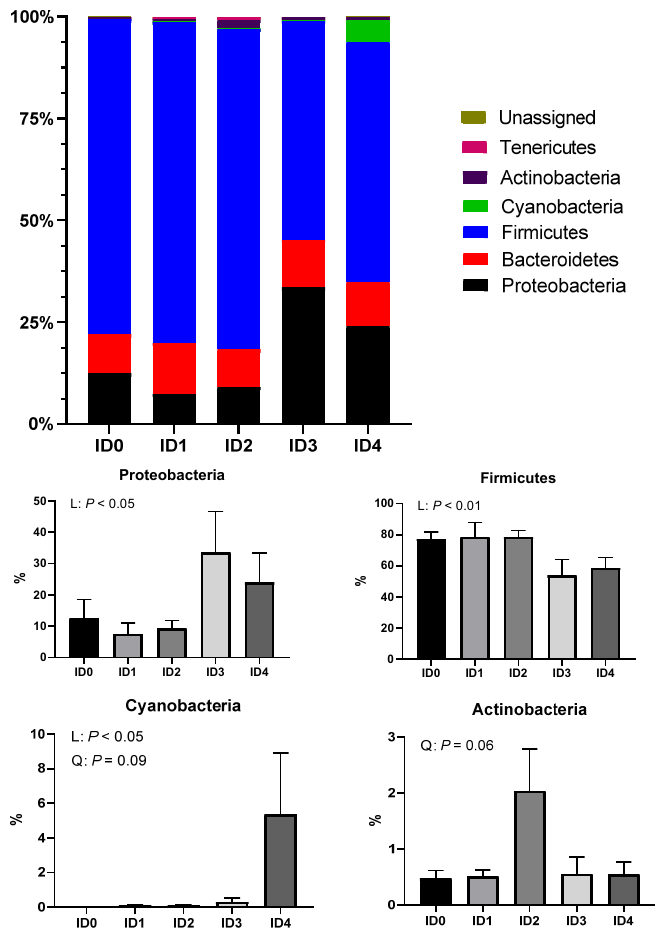
Figure 4. Effects of different infection doses of Eimeria tenella on phylum-level composition of the cecal microbial communities in broilers 6 days post-infection. Phylum-level composition was measured in the ID0 (infection dose 0; sham-challenged with phosphate-buffered saline); ID1 (infection dose 1; challenged with 6250 sporulated oocysts of Eimeria tenella ); ID2 (infection dose 2; challenged with 12,500 sporulated oocysts of E. tenella ); ID3 (infection dose 3; challenged with 25,000 sporulated oocysts of E. tenella ); ID4 (infection dose 4; challenged with 50,000 sporulated oocysts of E. tenella ) groups. Data were analyzed by using One-way ANOVA followed by the Tukey’s multiple comparison test. Orthogonal polynomial contrast analysis was used to assess linear (L) and quadratic (Q) effects of the infection doses, and p < 0.1 were